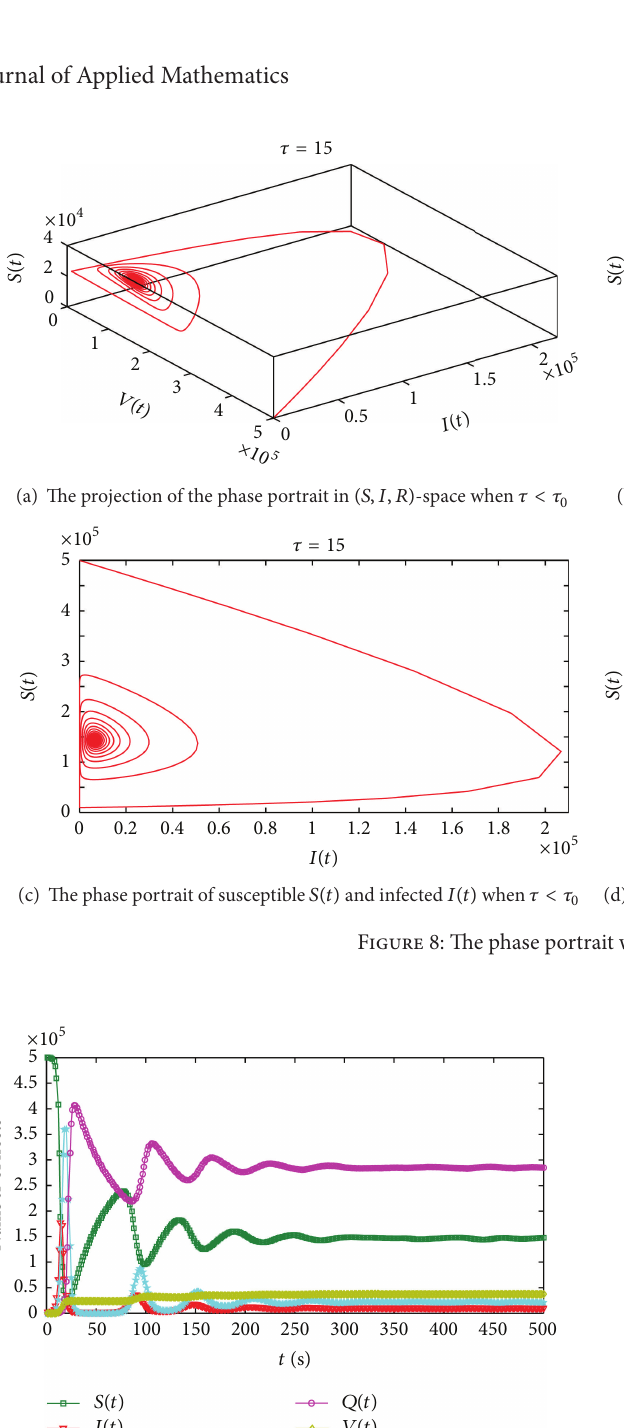
of these two curves are well matched, which suggests that the results of numerical and simulation experiments are identical. But there is a difference of 9.6% of total population size in amplitudes. This mainly results from the precision of experiments. The number of hosts in numerical experiments can be either integers or decimals because it is the solution of differential equations. However, in simulation experiments, the number of hosts must be integers. Furthermore, when